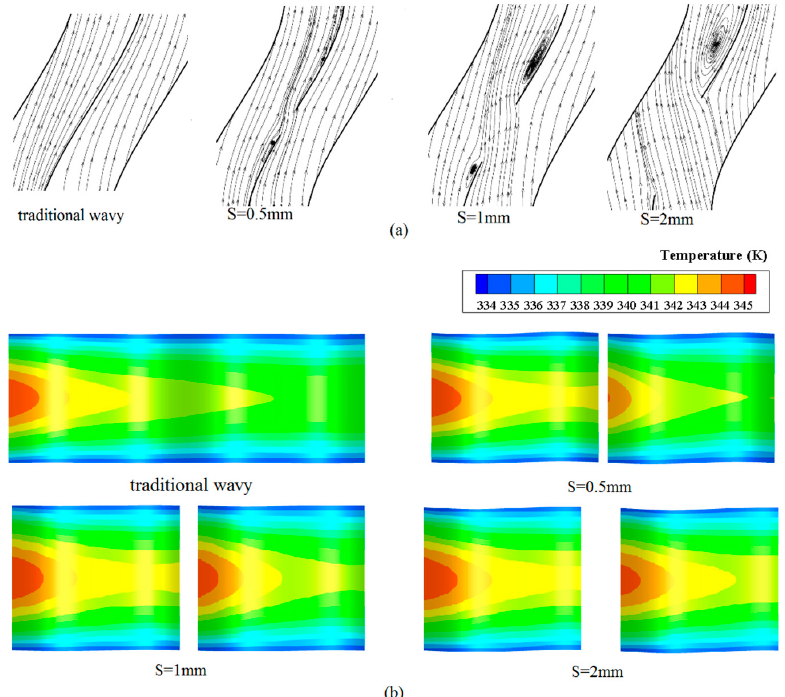
Figure 10. ( a ) Change in the streamline and ( b ) fin surface temperature distribution of the traditional wavy fin and discontinuous wavy fin when the breaking distances are 0.5 mm, 1 mm and 2 mm.